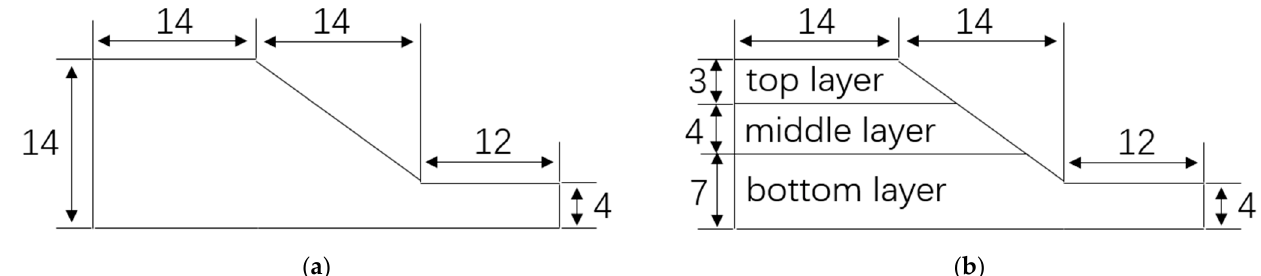
Figure 3. Illustrations of slope geometries: ( a ) uniform slope; ( b ) layered slope.